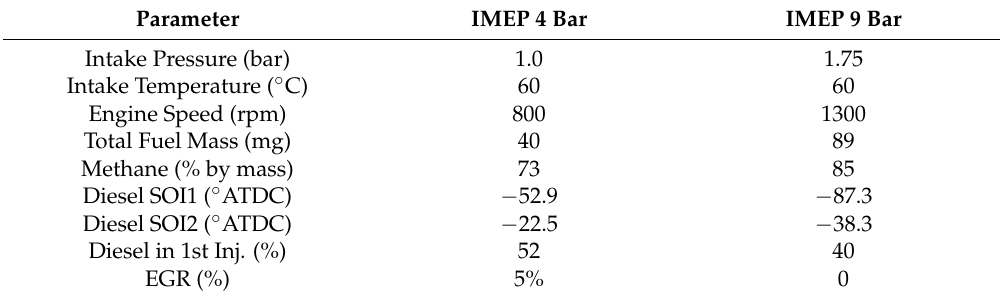
Table 2. The validation cases for natural gas/diesel reactivity controlled compression ignition (RCCI)